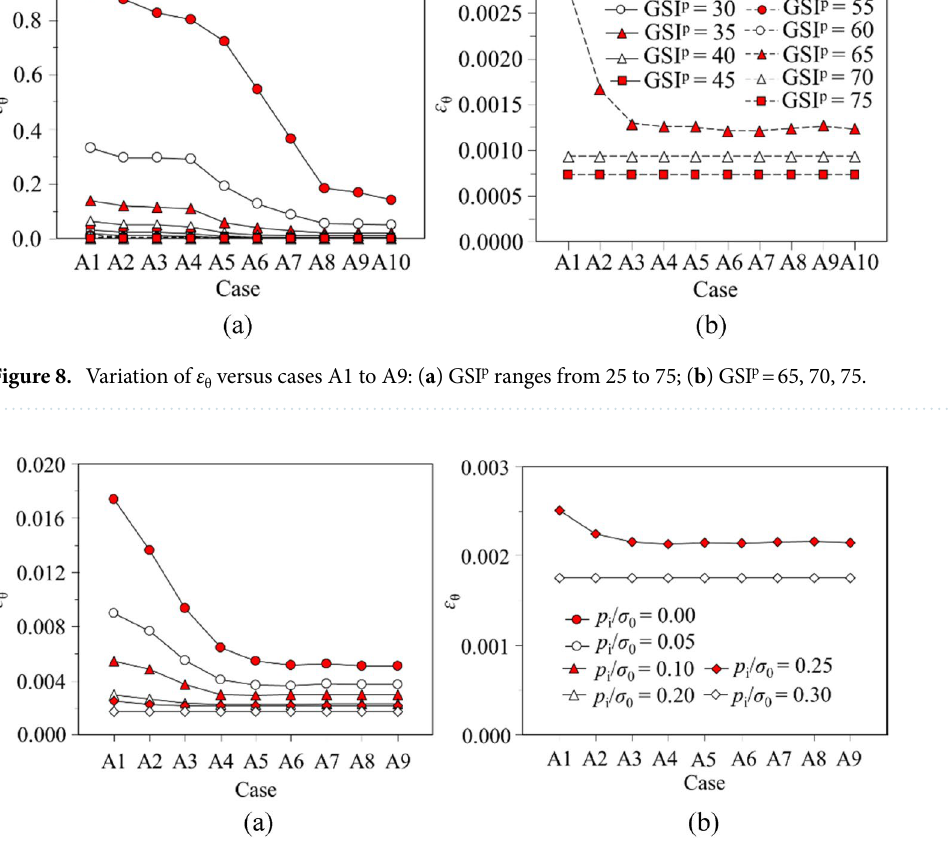
Figure 9. Variation of ε θ versus cases A1 to A9: ( a ) p i / σ 0 ranges from 0 to 0.3; ( b ) p i / σ 0 = 0.25, p i / σ 0 =